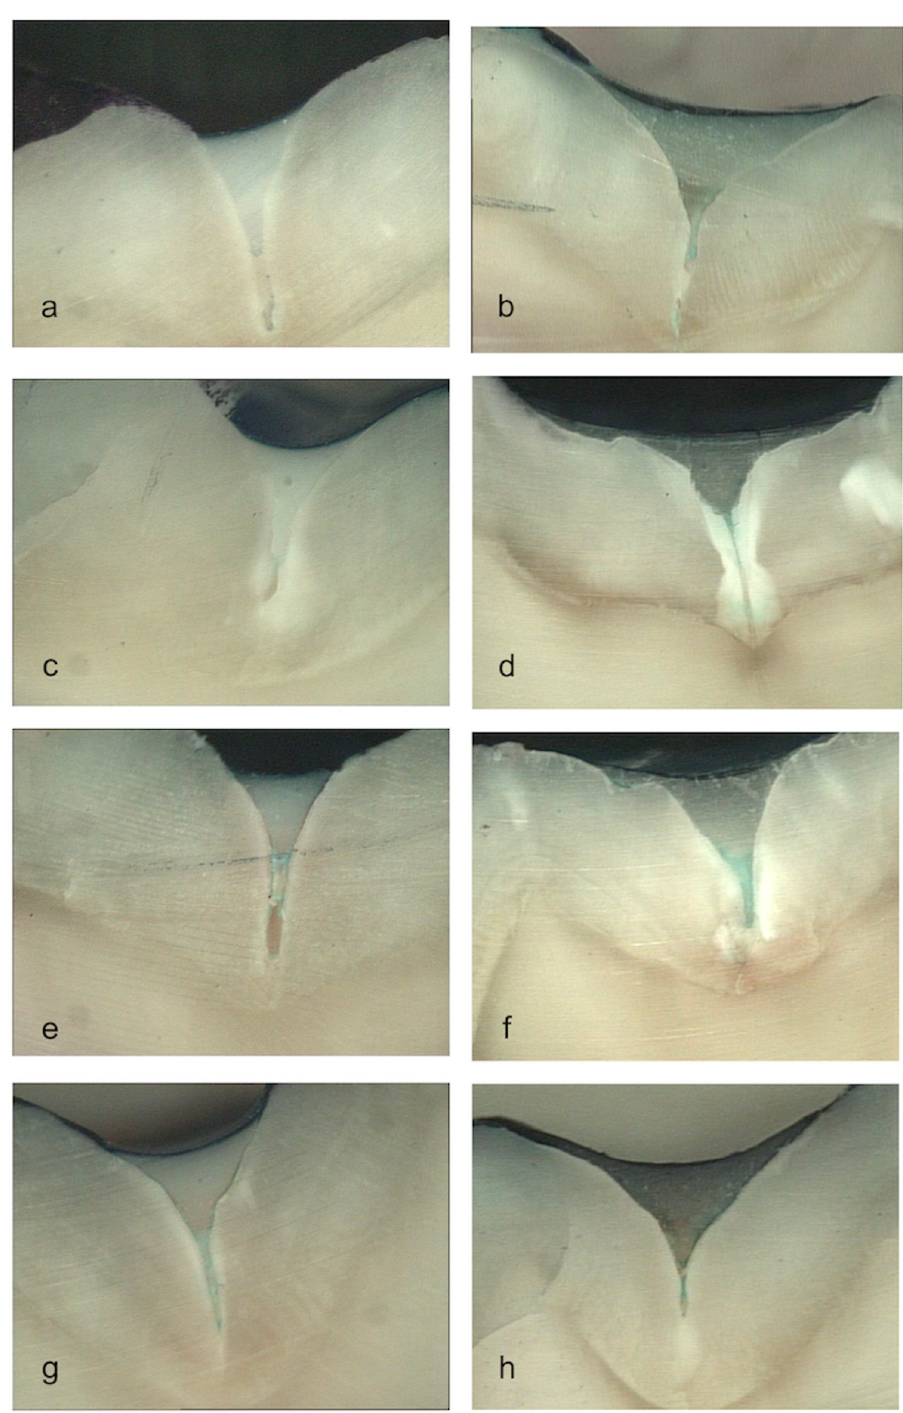
Fig 2. Images obtained in the stereomicroscope (x10). (a) Group 1: intact enamel + GrandiO Seal. (b) Group 2: intact enamel + Vitremer. (c) Group 3: demineralized enamel + GrandiO Seal. (d) Group 4: demineralized enamel + Vitremer. (e) Group 5: intact enamel + Bifluorid 12 + GrandiO Seal. (f) Group 6: intact enamel + Bifluorid 12 + Vitremer. (g) Group 7: demineralized enamel + Bifluorid 12 + GrandiO Seal. (h) Group 8: demineralized enamel + Bifluorid 12 +